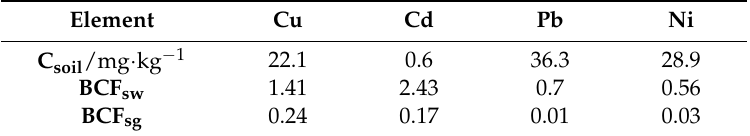
Table 5. Wheat absorption (BCF sw ) and grain absorption (BCF sg ) capacities for different trace metals.